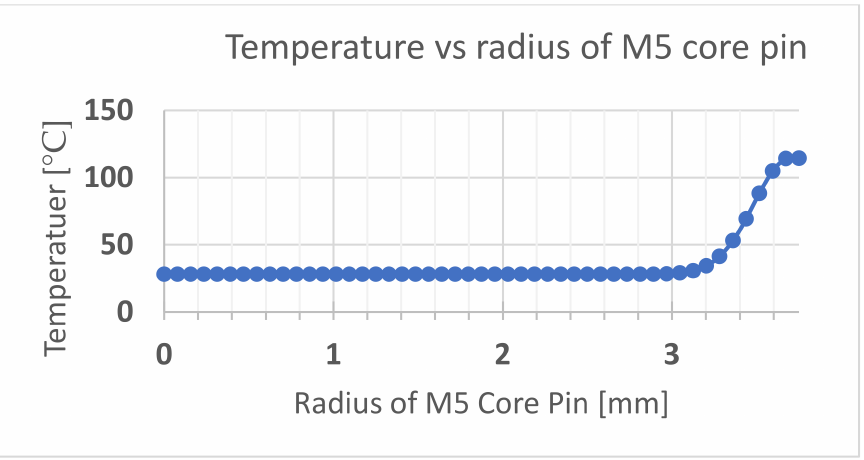
Figure 21. Temperature vs. the radius of the core pin measured at a height of 3.75 mm from the base of the pin. The theoretical analysis was repeated using the stress Equations (7) and (8). Results